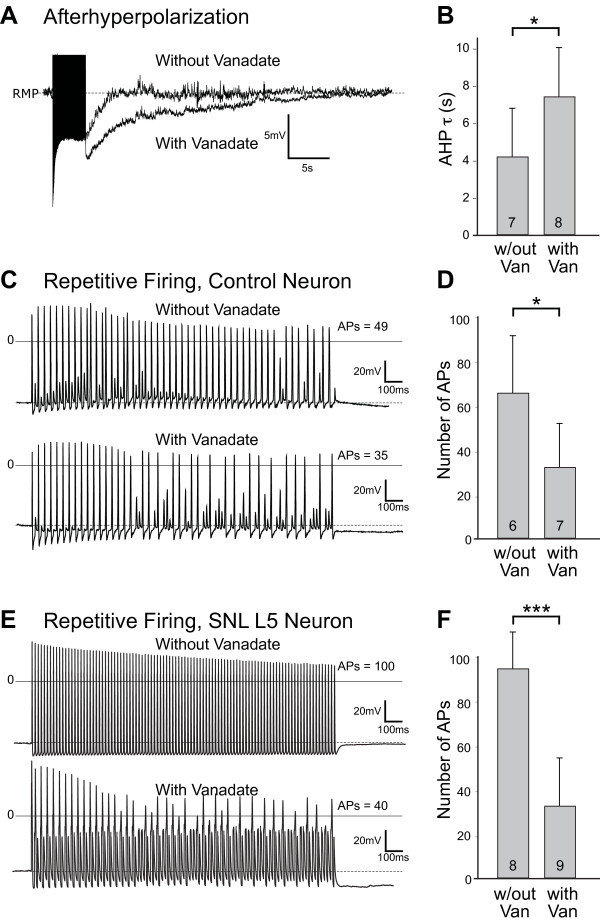
Regulation of neuronal excitability by PMCA. The afterhyperpolarization (AHP) that follows a train (50 Hz for 4 s) of action potentials (APs) generated by current injection (2x threshold) in control neurons are shown in sample traces (A) made by whole-cell patch-clamp recording 10 min after breakthrough, comparing a recording without vanadate to one in which the patch pipette contained vanadate (200 μM). The traces are aligned at their resting membrane potentials (RMP; -61 mV for the control neuron, -64 mV for the vanadate-treated neuron). The train of APs appears as a black band at the beginning of the trace with their amplitude truncated. Summary data (B) show that the duration of the AHP, measured as the time constant (τ) of a monoexponential fitted to the AHP, was prolonged by vanadate (Van) compared to other neurons without vanadate (w/out Van). The ability to generate APs was tested by determining the ability of a train (50 Hz for 2 s, total 100) of depolarizing stimuli (1.5x threshold) to generate APs. Sample traces in control neurons (C) show 49 full APs produced in a neuron without vanadate and 35 APs produced by comparable stimuli in a vanadate-treated neuron. Summary data (D) reveal a depression of AP generation by PMCA blockade with vanadate in control neurons. In neurons from the fifth lumbar dorsal root ganglia after spinal nerve ligation (SNL L5), sample traces (E) and summary data (F) show that the injury-induced difference in excitability is eliminated by vanadate treatment. Mean ± SD; numbers in bars indicate n; * P < 0.05, *** P < 0.001 by Mann Whitney test.